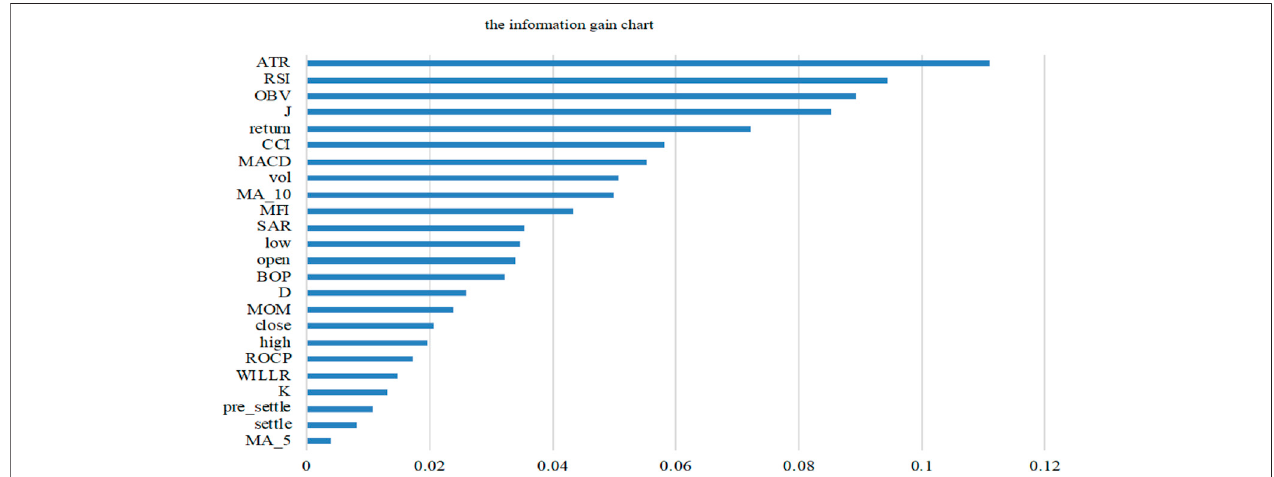
FIGURE 6 | The importance ranking of feature indicator variables based on information gain.